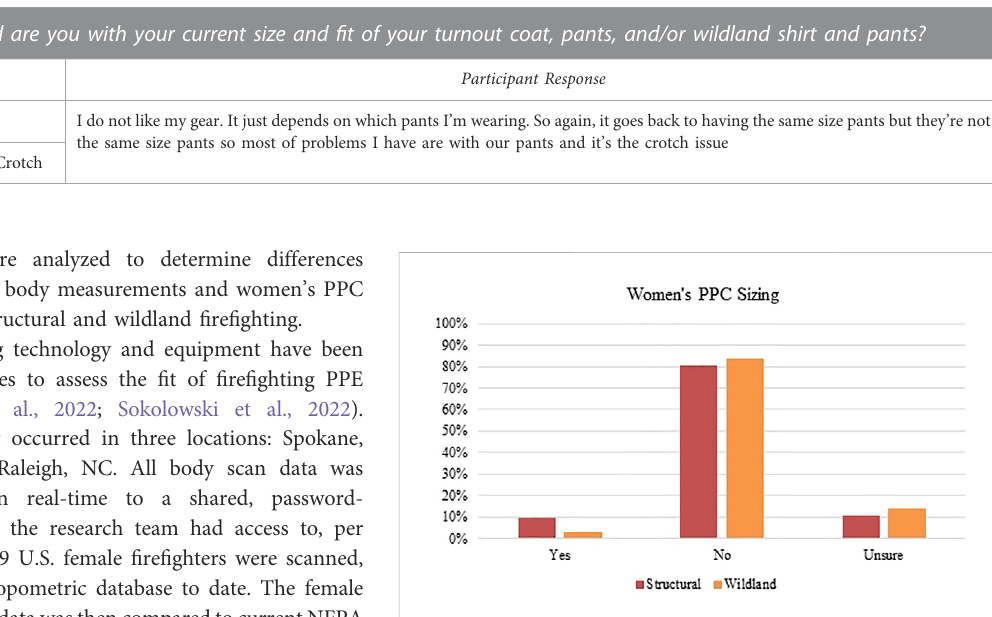
TABLE 2 Example coding of content analysis used for synthesis.